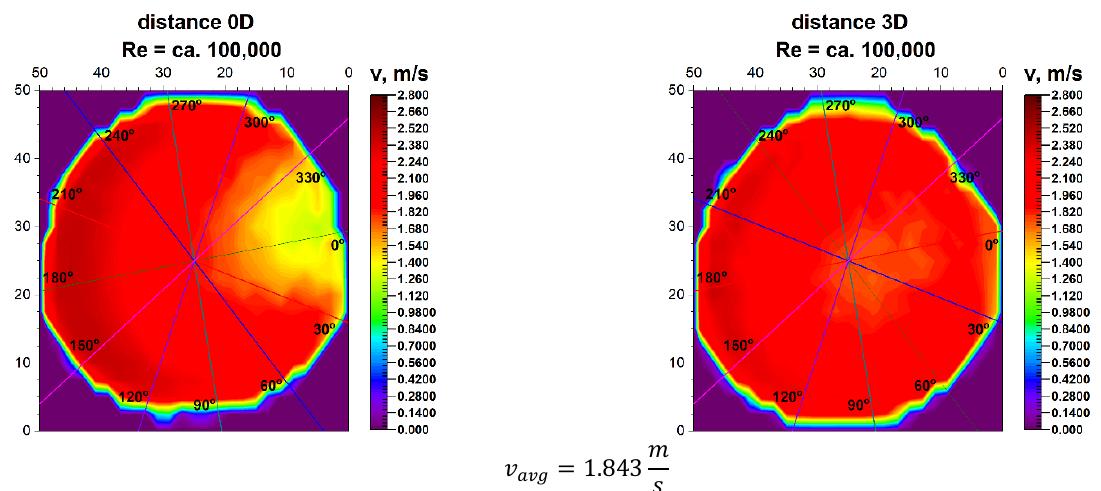
Figure 8. Comparison of projection on the velocity block at the distances 0D and 3D from the disturbance with marked cross-sections for Re ≅ 100,000.